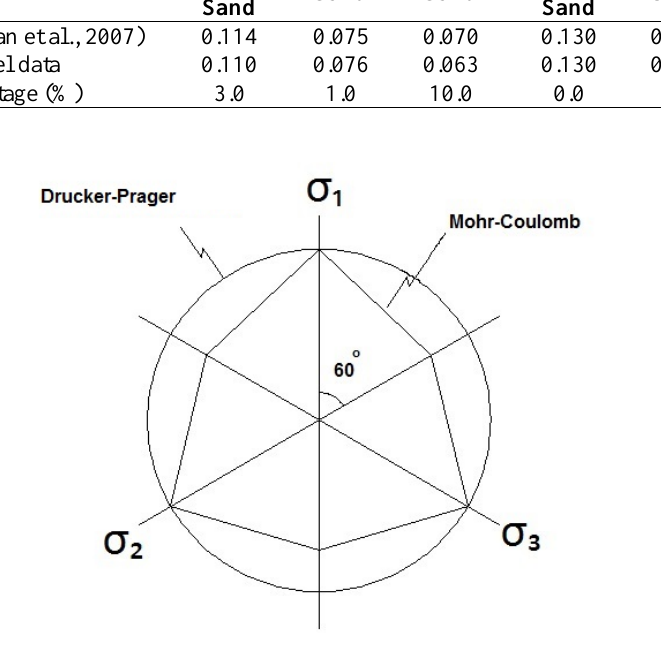
Fig. 1. Mohr- Coulomb criterion on П plane